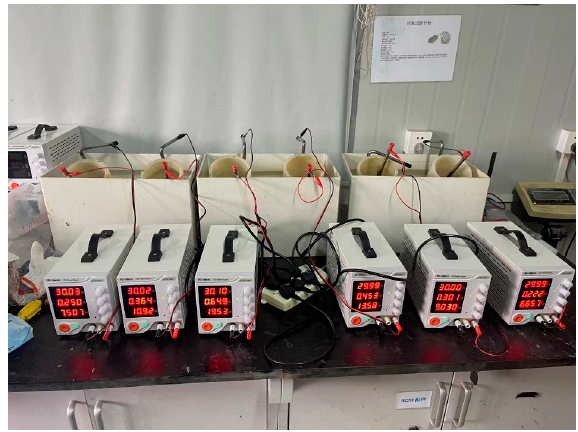
Figure 3. The experimental instrument used for the RCM test.